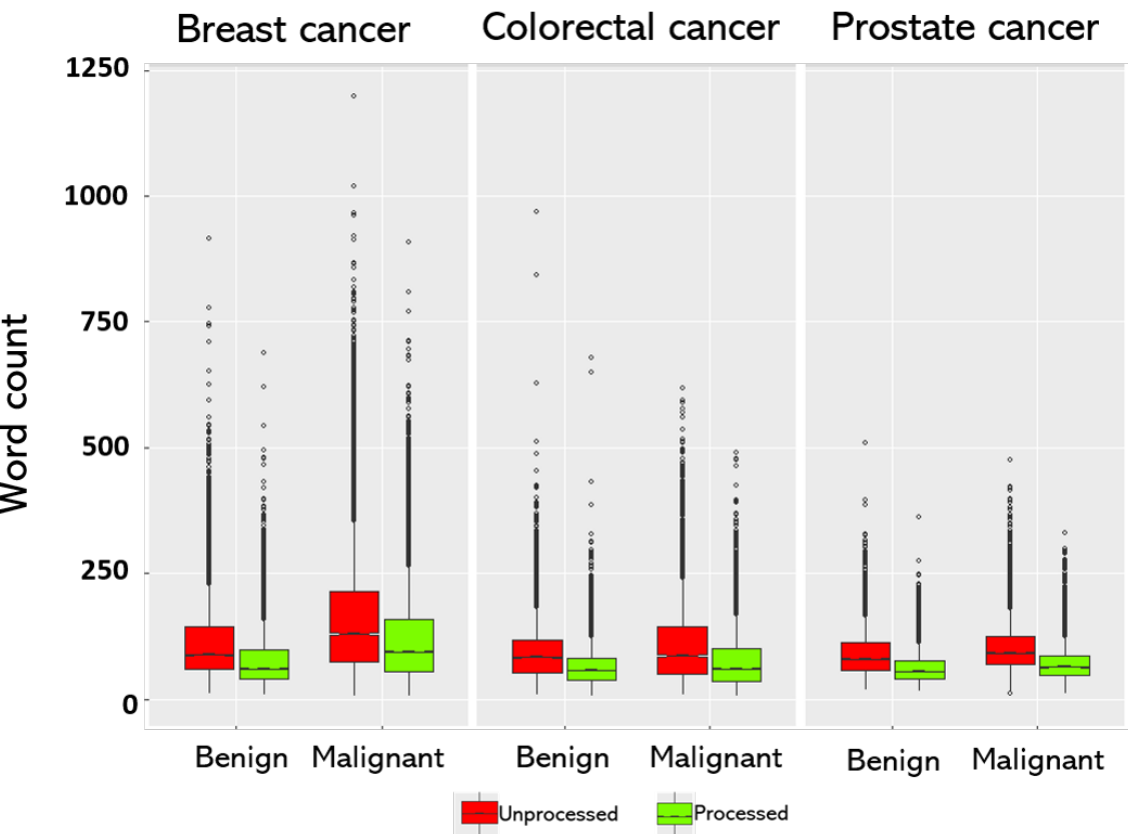
Figure 3. Box plots illustrating the distribution of word counts in the pathology report for the three cancer types. The figure shows reports with higher word counts, which skews the distribution of word counts in the reports. For each cancer target class, the number of word counts reduced after data